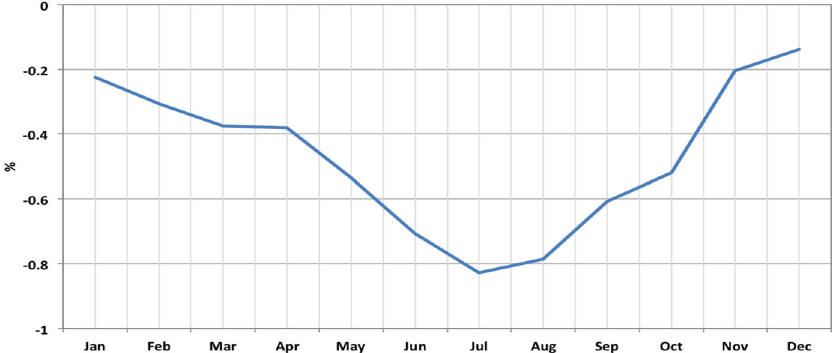
Fig. 5 Estimated average “end of month effect” on affiliations growth, all